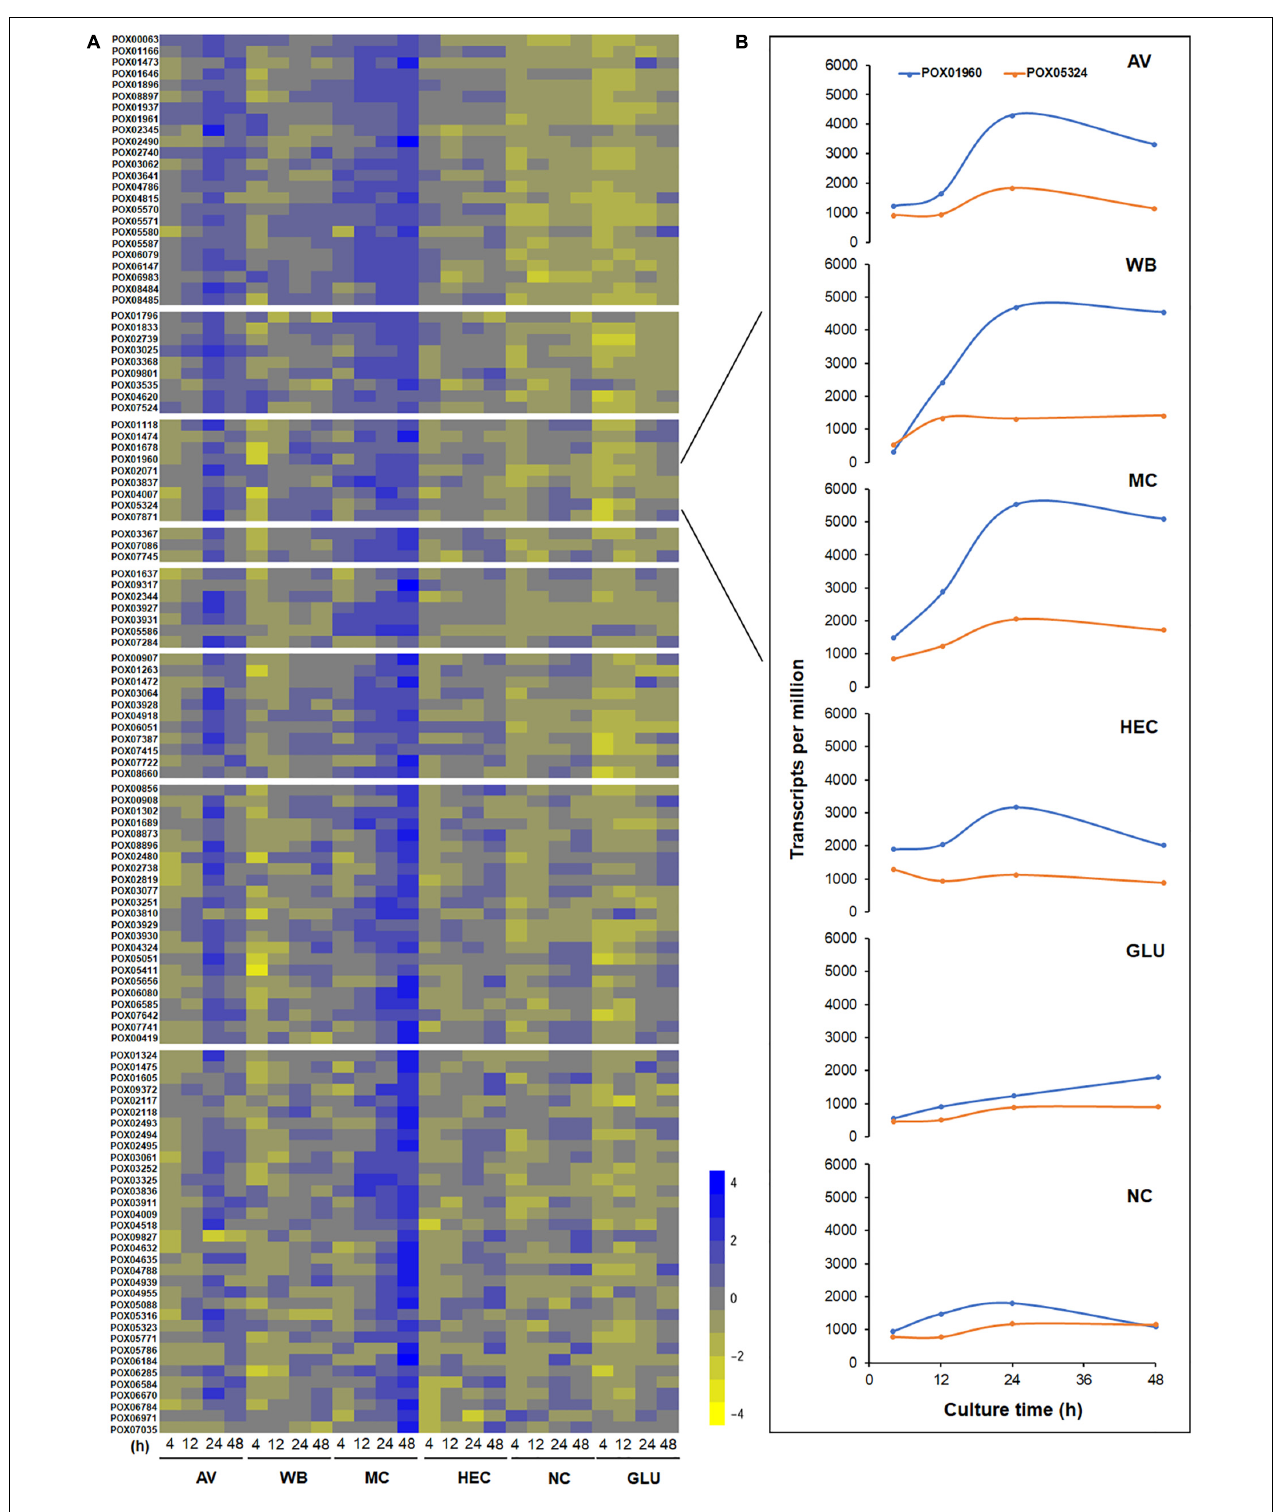
FIGURE 12 | Heatmap plot of gene expression levels in module MEivory (A) and a comparison of transcription levels between POX01960 and POX05324 (B) . The heatmap (A) is constructed based on log2 fold change of each gene on different carbon sources compared with that on NC; transcript plots (B) use the FPKM of each gene. AV, Avicel; WB, wheat bran; MC, methyl cellulose; HEC, 2-hydroxyethyl cellulose; GLU, glucose; NC, no carbon source; FPKM, fragments per kilobase of exon per million mapped reads.